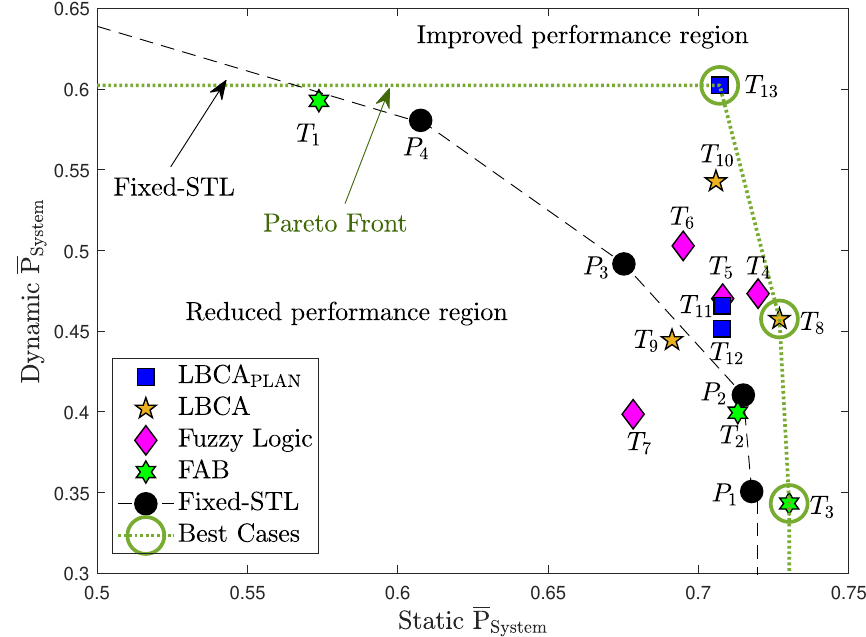
Figure 37. System performance comparison between dynamic and static